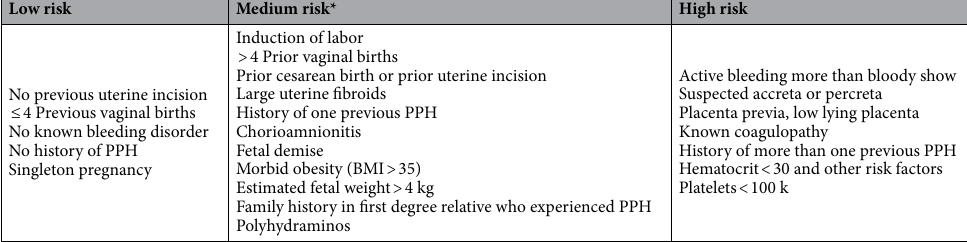
Table 1. AWHONN hemorrhage risk assessment 29 . AWHONN Association of Women’s Health, Obstetric and Neonatal Nurses, PPH Postpartum hemorrhage, BMI body mass index. *If two or more mediumrisk items are found then that classifies as ’high